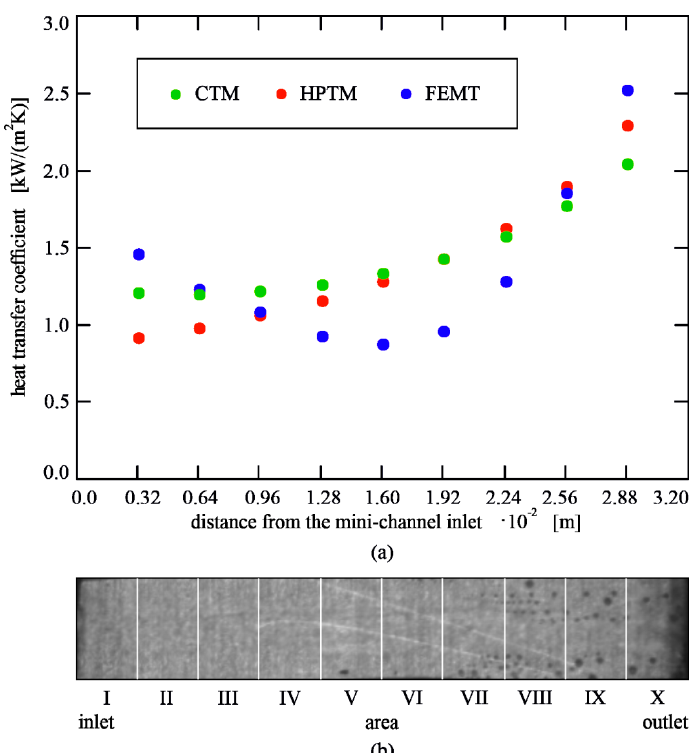
Figure 8. ( a ) Heat transfer coefficient versus distance from the mini-channel inlet, ( b ) two-phase flow pattern, t = 420 s; other experimental parameters are listed in Table 1. Energies 2021 , 14 , x FOR PEER REVIEW